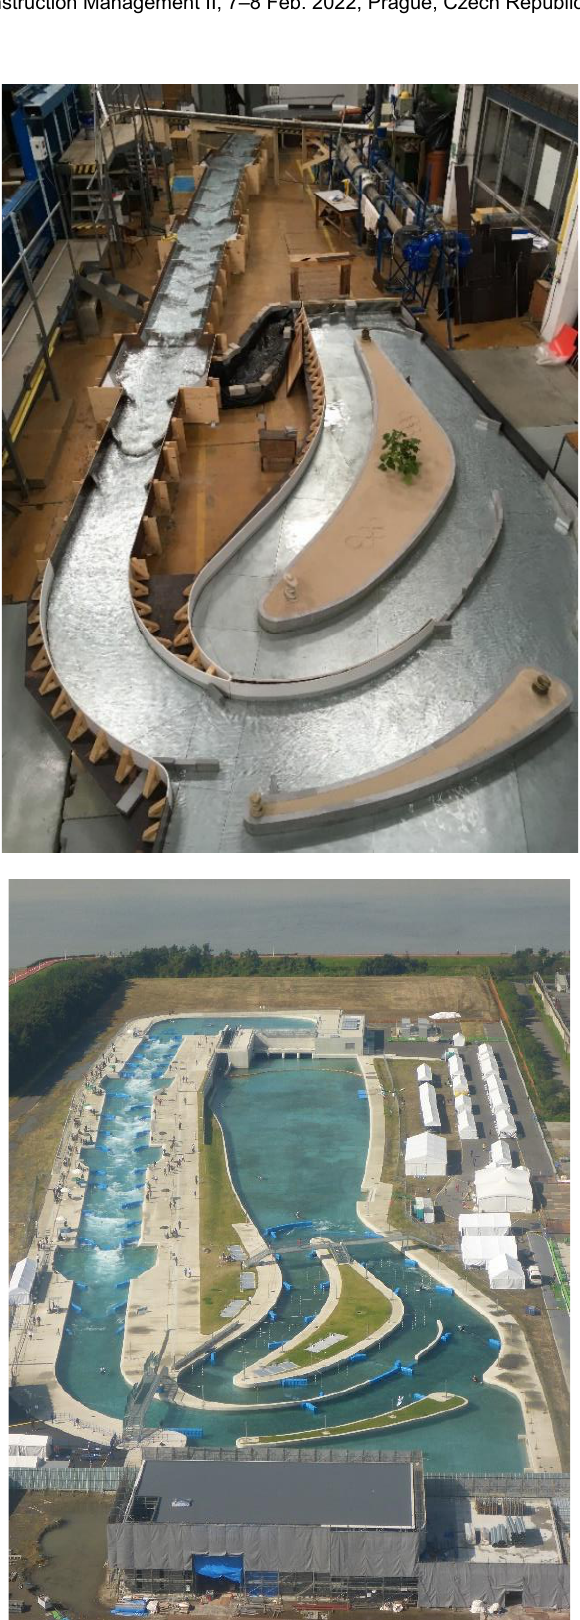
Figure 8. a,b View on laboratory model in scale 1 : 13 and finished full size Tokyo Olympic slalom